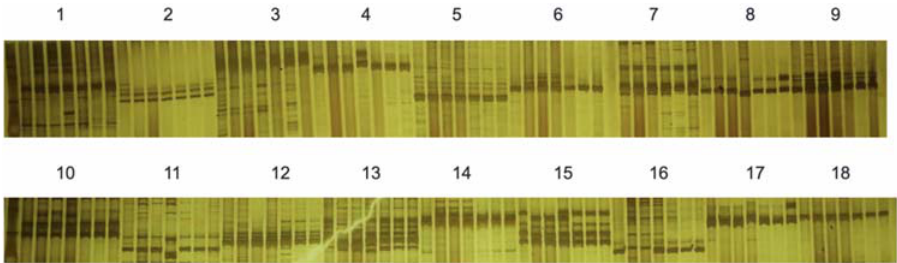
Figure 8. PCR amplification of nine pairs of SSR primers in 18 ‐ 512 sister lines (18 ‐ 512, 18 ‐ 2169 ‐ 1, 18 ‐